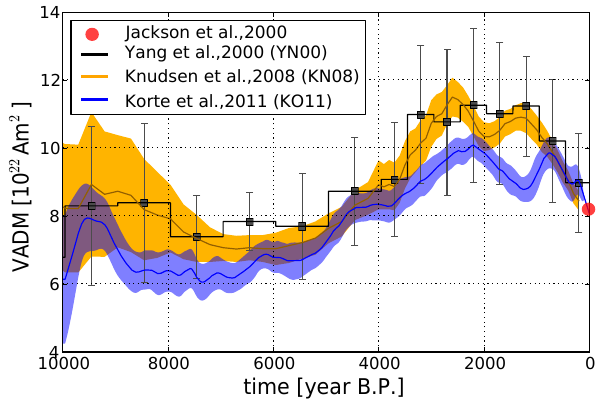
Fig. 11. Reconstructions of the virtual axis dipole moment (VADM) of the geomagnetic field for the Holocene. Black: Yang et al. (2000), orange: Knudsen et al. (2008), blue: Korte et al. (2011). For the most recent epoch, the estimate of Jackson et al. (2000) yields 8.22 × 10 22 Am 2 (red dot). In the present study, the data of Korte et al. (2011) is